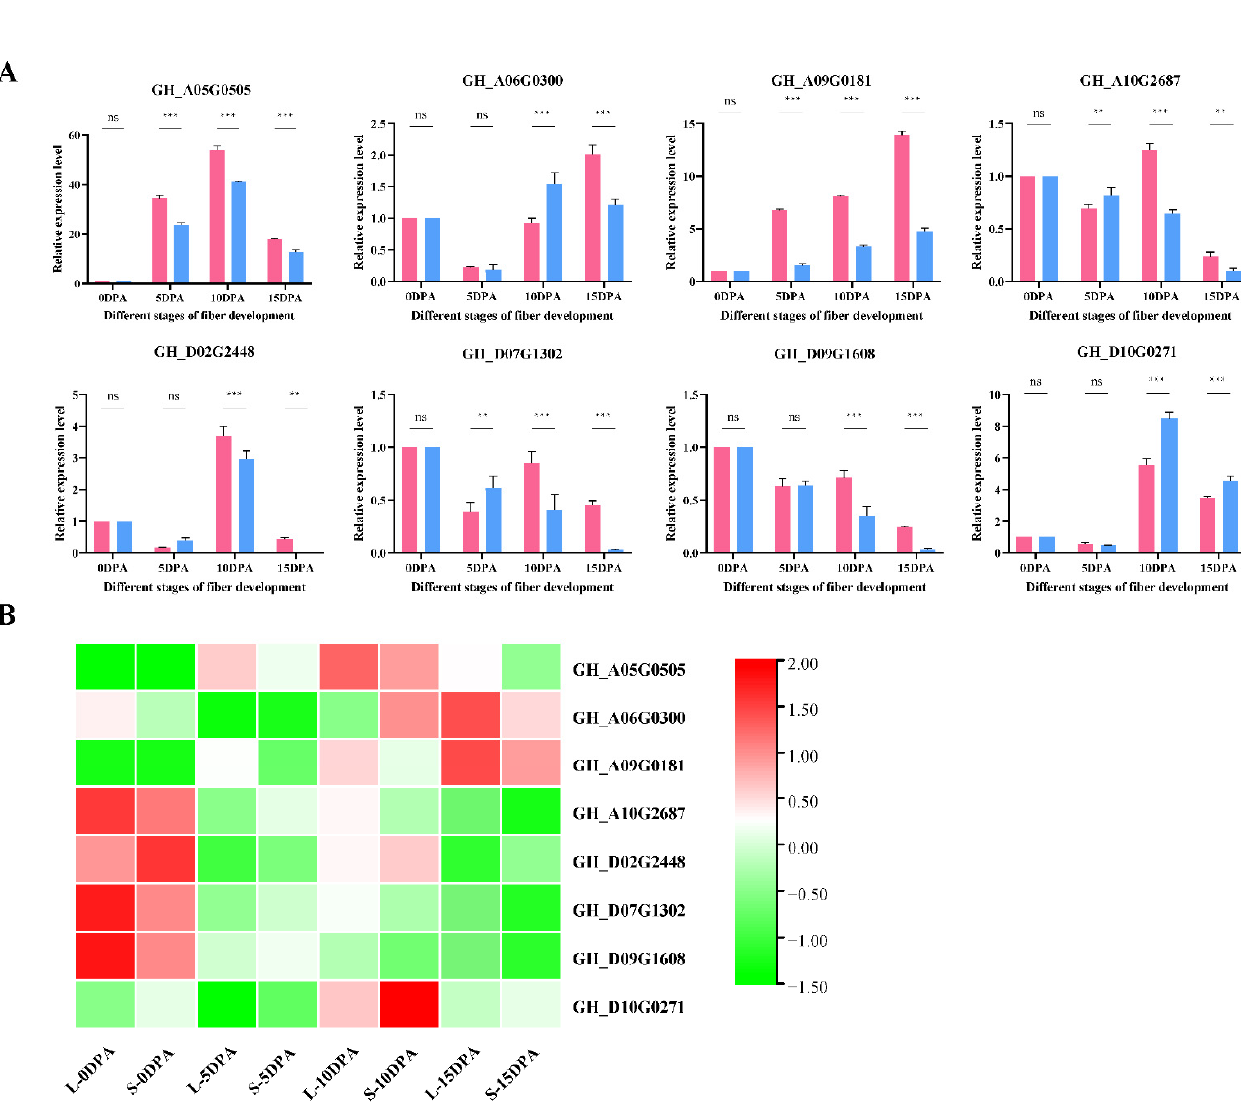
Figure 2. Confirmation of RNA-seq results using qRT–PCR experiments. ( A ) qRT–PCR results of 8 genes. With associated significance levels ( p values) added above each histogram. ns indicates no significant effect at the p < 0.05 level, and ** and *** represent significant effect at the p < 0.01 and p < 0.001 levels, respectively. Pink bars, L; blue bars, S. ( B ) RNA-seq heatmap of 8 genes.